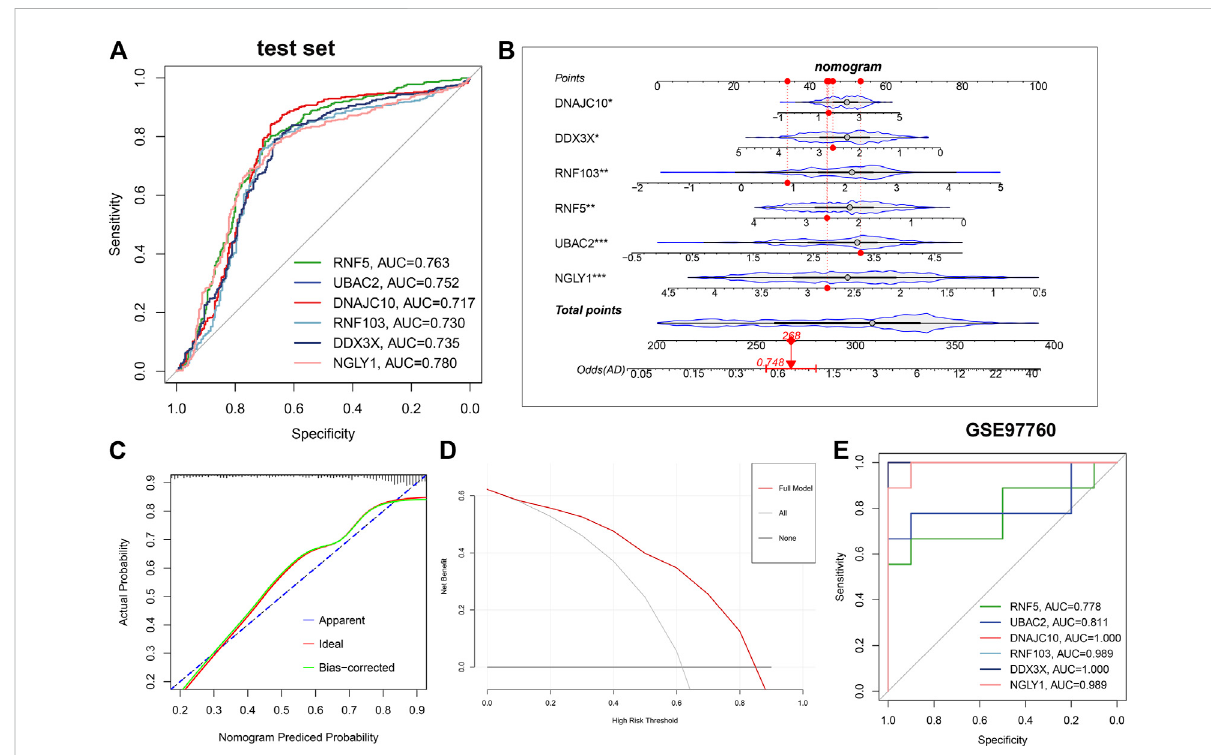
FIGURE 8 Validation of the diagnostic ef fi cacy based on characteristic genes. (A) ROC curves evaluating the diagnostic performance of feature genes in the testing set. (B) Establishment of a nomogram for predicting the risk of AD on the basis of feature genes in the testing set. (C) Calibration